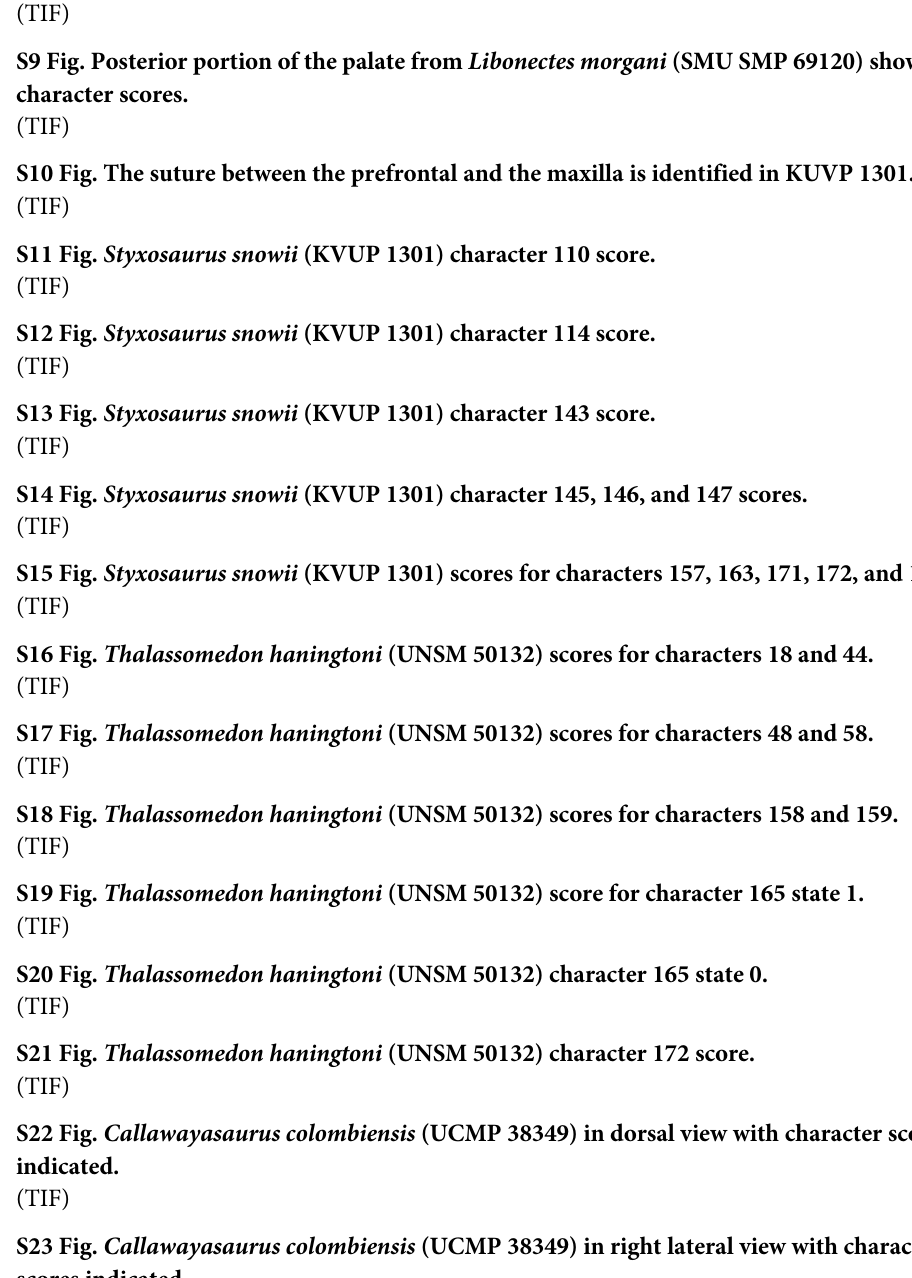
S7 Fig. Anterior end of the palate of Libonectes morgani (SMU SMP 69120) with character scores indicated. (TIF) S8 Fig. Oblique view of quadrate ramus of the pterygoid indicating the absence of a lappet. Interpretation is based on a high-resolution cast of Libonectes morgani (SMU SMP 69120) based on CT data. (TIF) S9 Fig. Posterior portion of the palate from Libonectes morgani (SMU SMP 69120) showing character scores. (TIF) S10 Fig. The suture between the prefrontal and the maxilla is identified in KUVP 1301. (TIF) S11 Fig. Styxosaurus snowii (KVUP 1301) character 110 score. (TIF) S12 Fig. Styxosaurus snowii (KVUP 1301) character 114 score. (TIF) S13 Fig. Styxosaurus snowii (KVUP 1301) character 143 score. (TIF) S14 Fig. Styxosaurus snowii (KVUP 1301) character 145, 146, and 147 scores. (TIF) S15 Fig. Styxosaurus snowii (KVUP 1301) scores for characters 157, 163, 171, 172, and 175. (TIF) S16 Fig. Thalassomedon haningtoni (UNSM 50132) scores for characters 18 and 44. (TIF) S17 Fig. Thalassomedon haningtoni (UNSM 50132) scores for characters 48 and 58. (TIF) S18 Fig. Thalassomedon haningtoni (UNSM 50132) scores for characters 158 and 159. (TIF) S19 Fig. Thalassomedon haningtoni (UNSM 50132) score for character 165 state 1. (TIF) S20 Fig. Thalassomedon haningtoni (UNSM 50132) character 165 state 0. (TIF) S21 Fig. Thalassomedon haningtoni (UNSM 50132) character 172 score. (TIF) S22 Fig. Callawayasaurus colombiensis (UCMP 38349) in dorsal view with character scores indicated. (TIF) S23 Fig. Callawayasaurus colombiensis (UCMP 38349) in right lateral view with character scores indicated.